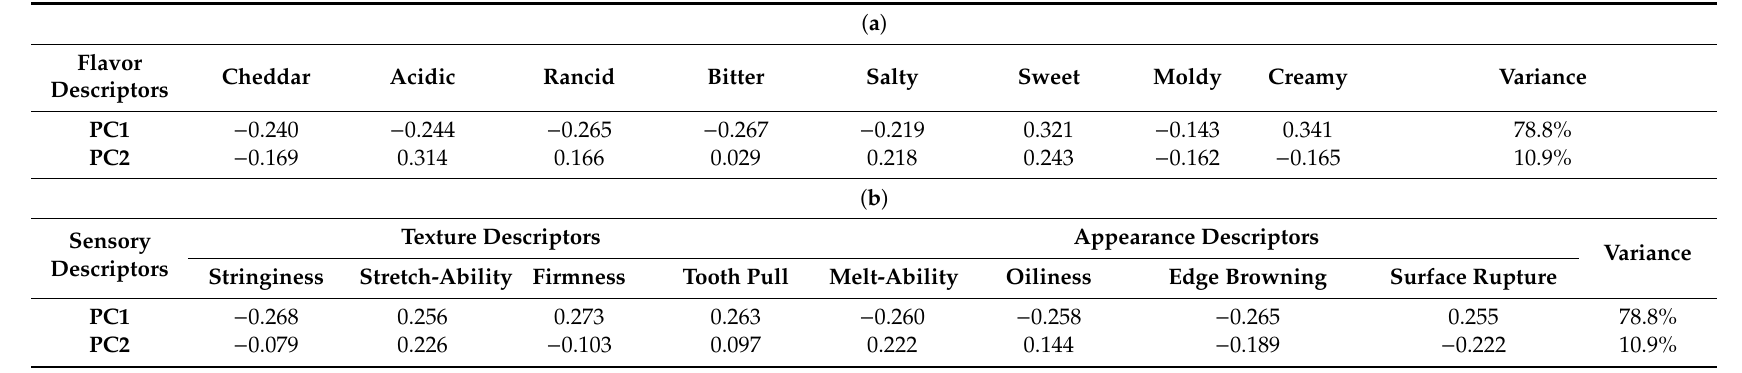
Table 6. Result of PCA on the descriptive sensory data of Pizza cheese showing the loadings of each variable on the first two principal components. ( a